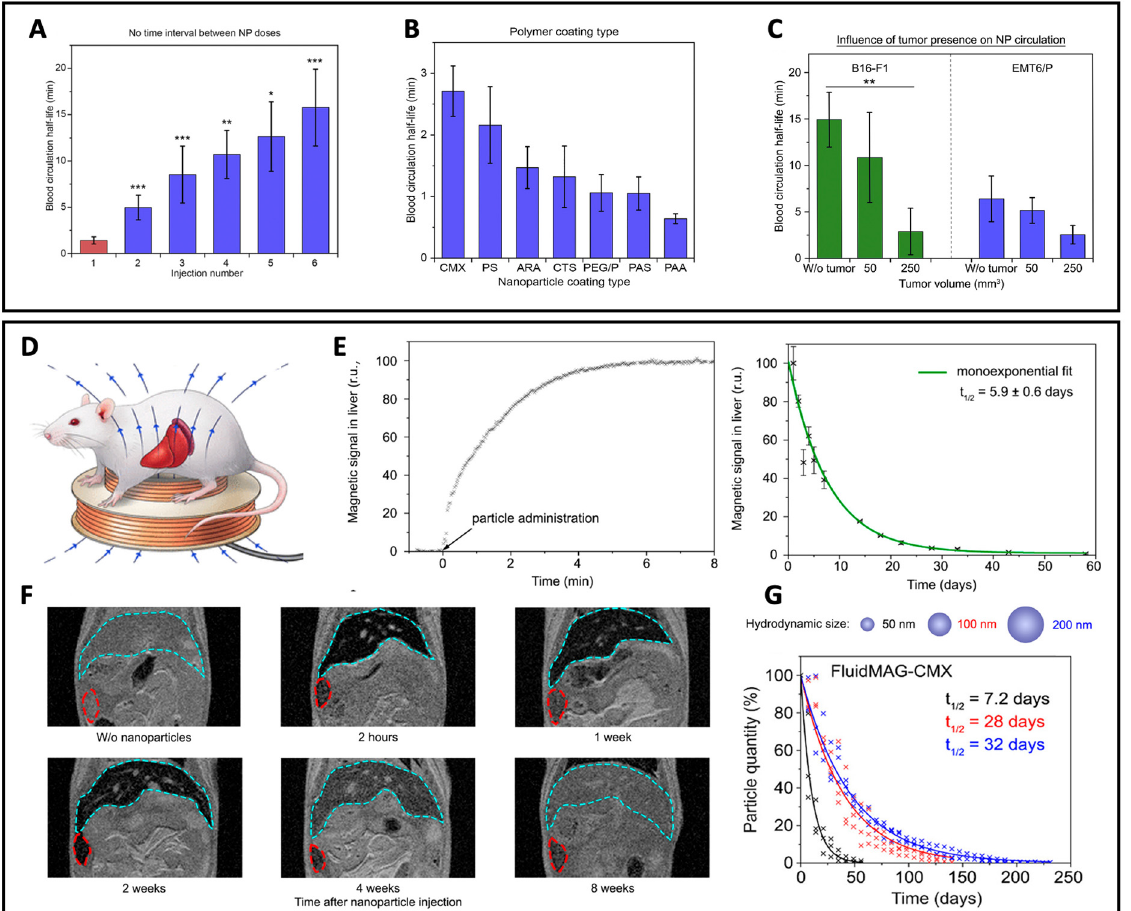
Figure 5. Circulation and distribution of MCs injected systemically. MPQ was applied to test the blood circulation and the organ distribution of magnetic particles. ( A ) Influence of repetitive injec- tions of 100-nm MCs on their circulation. Multiple injections of MCs (300 µg) were provided imme- diately after the clearance of the previous dose. ( B ) Dependence of the half-life time of 100-nm na- noparticles on polymer coating. The data are provided for a dose of 300 µg nanoparticles per mouse. ( C ) Influence of the presence and size of tumors (B16-F1 in C57Bl/6 and EMT6/P in BALB/c mice) on clearance of 50-nm MCs from the bloodstream. The data are provided for a dose of 300 µg nanopar- ticles per mouse. ( A – C ) The experiments were performed on BALB/c mice (blue and red bars) and on C57Bl/6 mice (green bars), n = 3 for each bar. Asterisks indicate significant difference from the control: Welch's t-test, *— p < 0.05; **— p < 0.01; ***— p < 0.001. Adapted with permission from Ref. [182]. ( D ) The degradation of magnetic particles is investigated with the MPQ approach noninva- sively in a setup where the magnetic signal from the particles is measured by a magnetic coil placed under the mouse liver and spleen. ( E ) MPQ data of accumulation and degradation kinetics in the liver of 100 µg of citrate-stabilized MPs, and ( F ) representative MRI of the two-month evolution studies in the liver (cyan lines) and spleen (red). ( G ) Dependence of degradation kinetics on particle size for 50, 100, 200 nm MPs coated with carboxymethyldextran. ( D – G ) . Adapted with permission from Ref. [195]. Copyright 2021 American Chemical Society. 3.2. MNPs for Scaffold Enrichment and Release of Drug/Cells MCs at the nano- and microscale are useful for drug delivery, as conceived as inject- able formulations and cell-interactive materials. For instance, drug-loaded MNPs can be systemically administered via intravenous injection and then magnetically guided to a